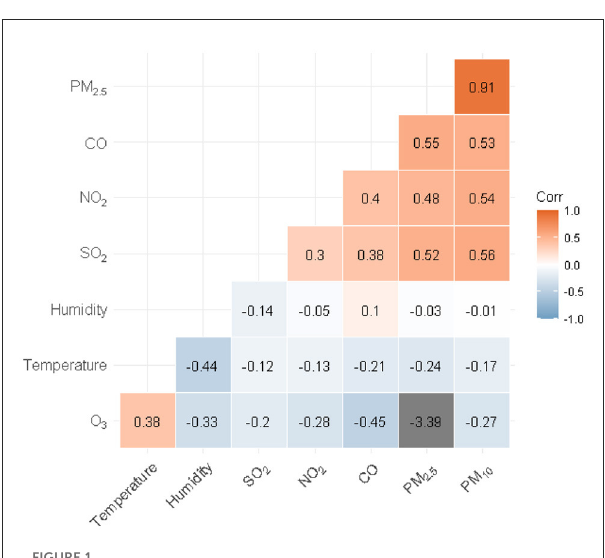
FIGURE1 Correlation analysis results for air pollutants and meteorological